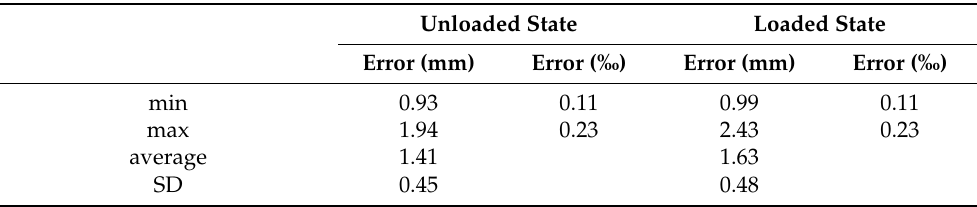
Table 1. Minimum, maximum, average, and standard deviation (SD) values of the errors in the distances between five pairs of checking points for the unloaded and loaded states.